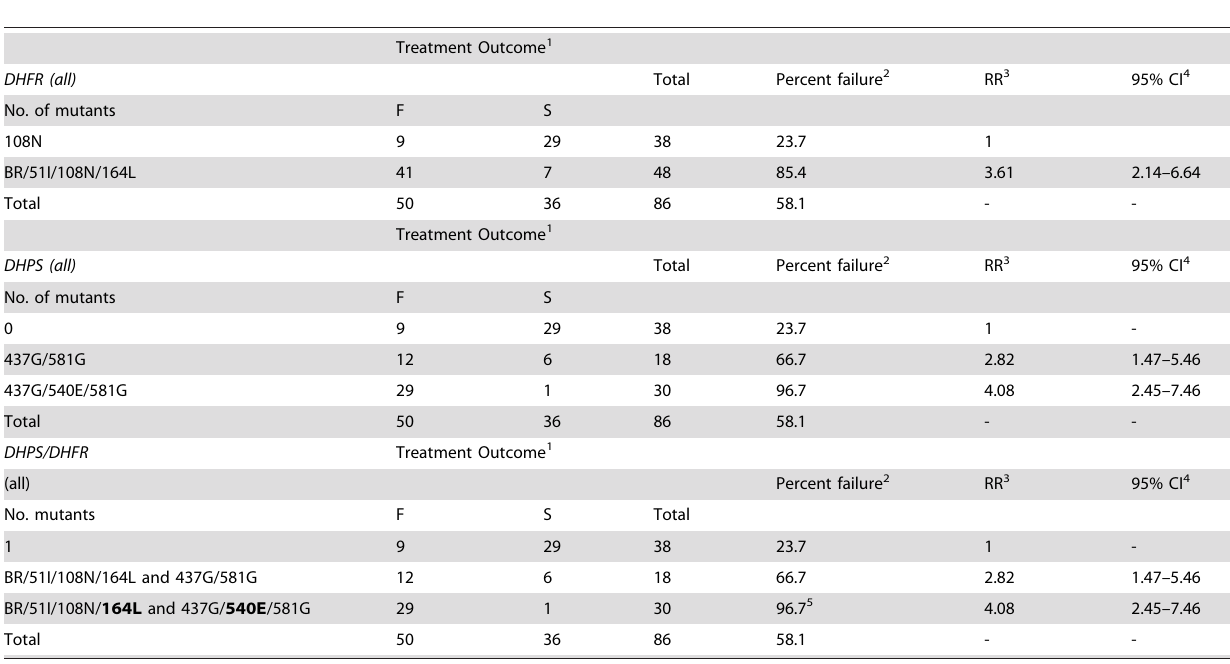
Table 2. Risk of treatment failure associated with occurrences of mutant alleles from DHPS, DHFR, and in combination.